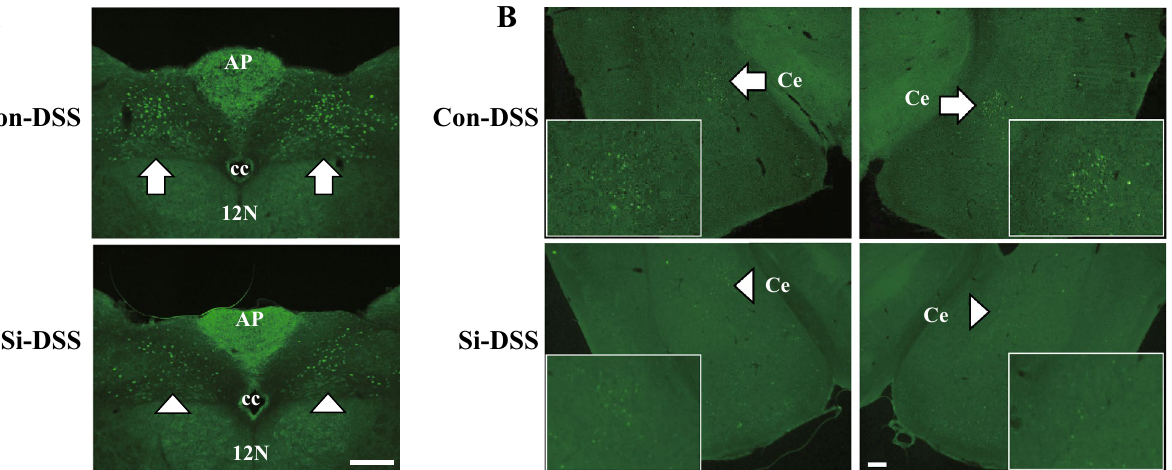
Figure 8. Si-based agent alleviated the visceral pain and discomfort associated with UC. Analysis of the neuronal activity influenced by colitis, using immunofluorescence staining with anti-c-Fos antibodies. ( A , B ) The representative photographs of the dorsal medulla ( A ) and central amygdaloid nuclei ( B ) 5 days after 5% DSS treatment. Con Con-DSS group, Si Si-DSS group. The vagal dorsal motor nuclei and solitary tract nuclei ( A ), and central amygdaloid nuclei ( B ) of a control mouse (arrow) and an Si-based agent-treated mouse (arrowhead). Square in ( B ): the central amygdaloid nuclei, 12N: hypoglossal nerve nuclei, AP: area postrema, cc: central canal, and Ce: central amygdaloid nuclei. Scale bar: 200